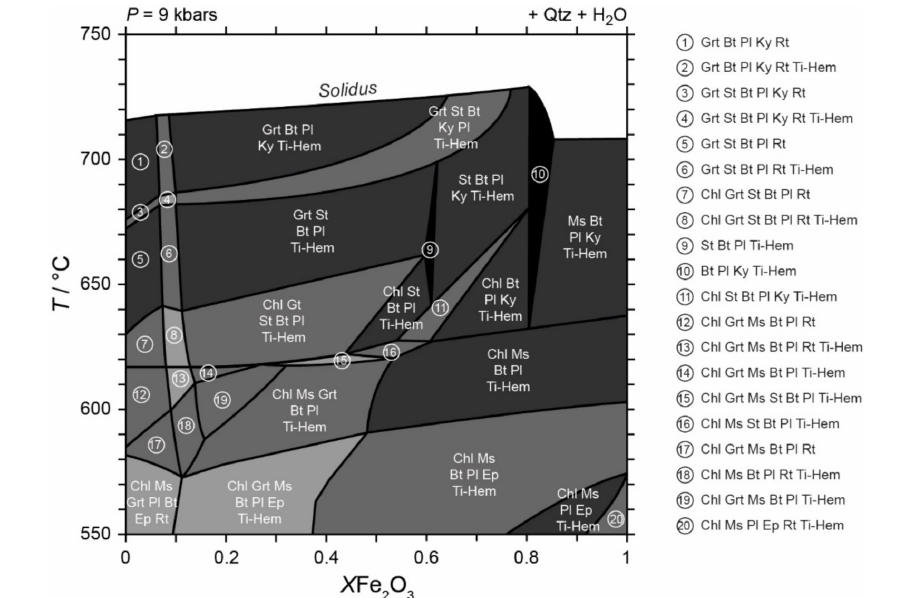
Figure A2. T-XFe 2 O 3 pseudosection calculated for 9 kbars and 550–750 ◦ C for sample CS16_292b. Assemblage fields are shaded according to the number of degrees of freedom, with higher-variance assemblages represented by darker shading. Mineral abbreviation: biotite (Bt), chlorite (Chl), epidote (Ep), garnet (Grt), kyanite (Ky), muscovite (Ms), plagioclase (Pl), quartz (Qtz), rutile (Rt), staurolite (St) and Ti-hematite